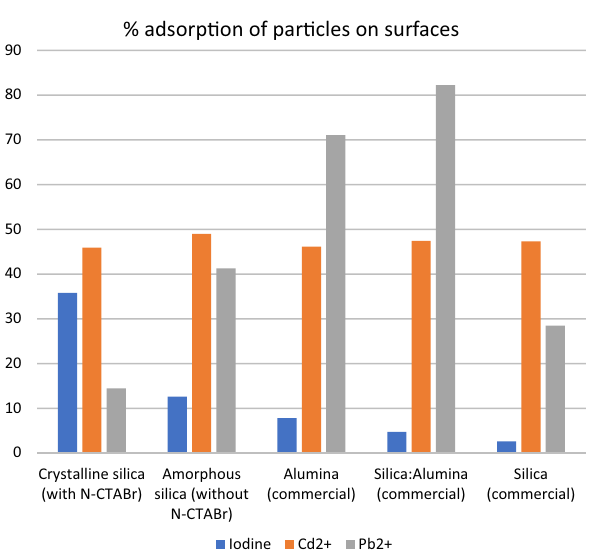
Figure 9. Adsorption of silica